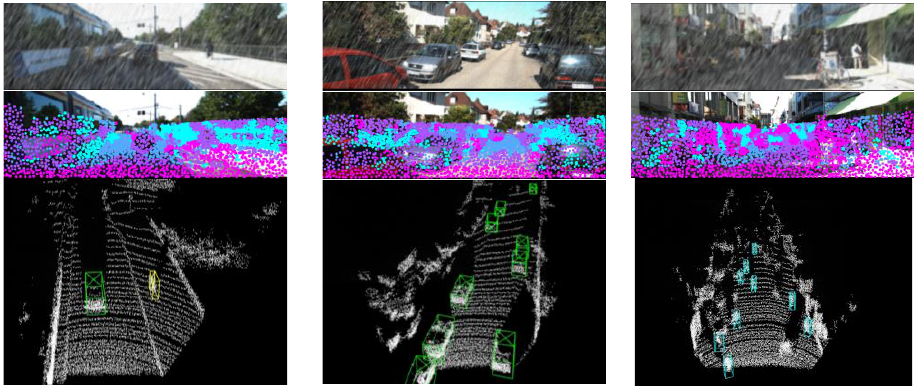
Figure 14. Visualization of MFA. Green/blue/yellow boxes indicate Car/Pedestrian/Cyclist.